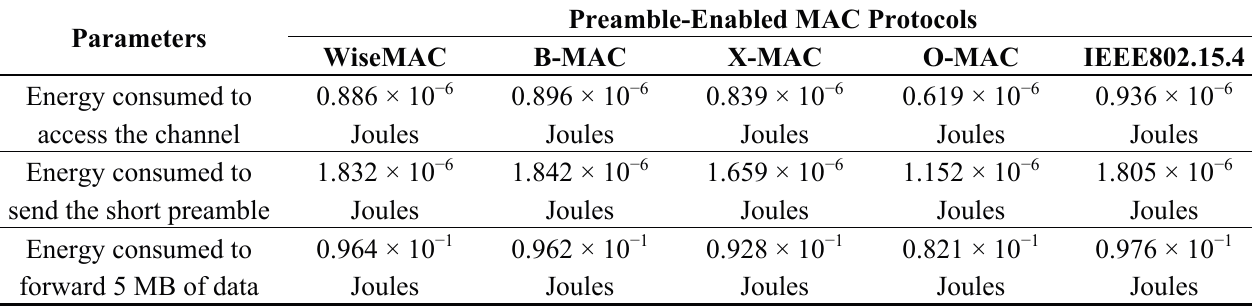
Table 4. Time and energy consumption of MAC protocols.